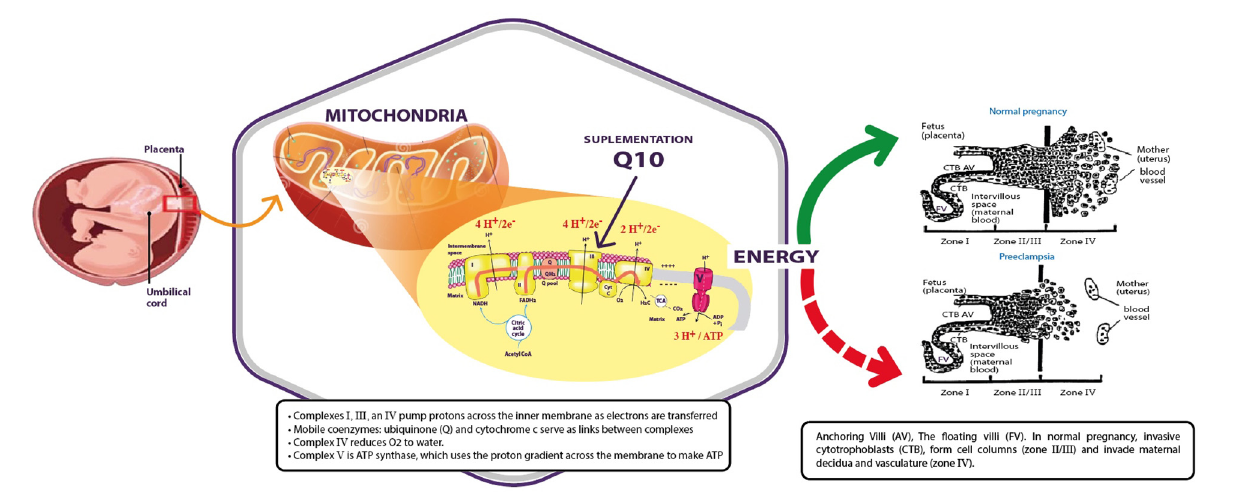
FIGURE 1 | Mitochondria produce energy for placental development during normal pregnancy (green arrow) that is abnormal in preeclamptic women (red dashed arrow). Supplementation of coenzyme Q10 might restore the activity of the